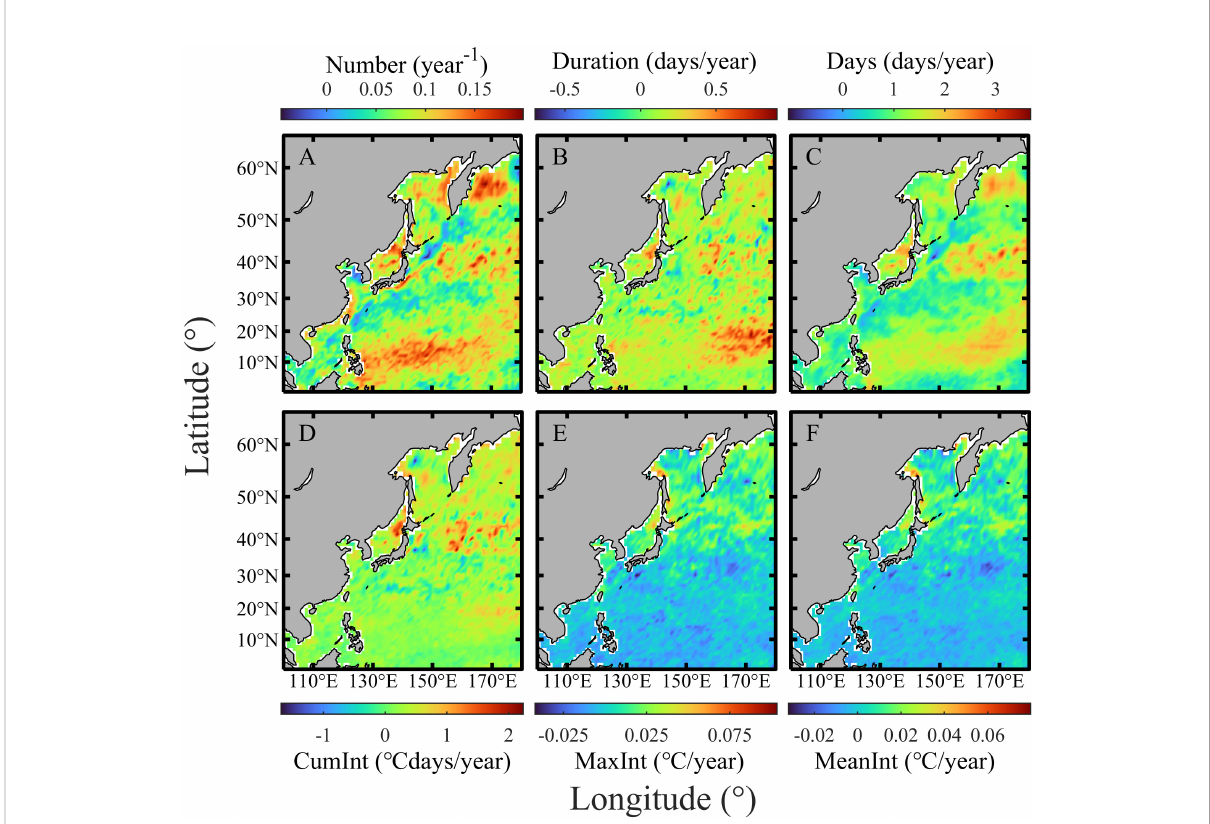
FIGURE 5 Spatial distribution of the MHWs characteristics trend during the historical period based on OISSTV2 data. Variation trend of MHWs (A) Number (units: year-1), (B) Duration (units: day), (C) Days (units: day), (D) CumInt (units: °C days), (E) MaxInt (units: °C), and (F) MeanInt (units: